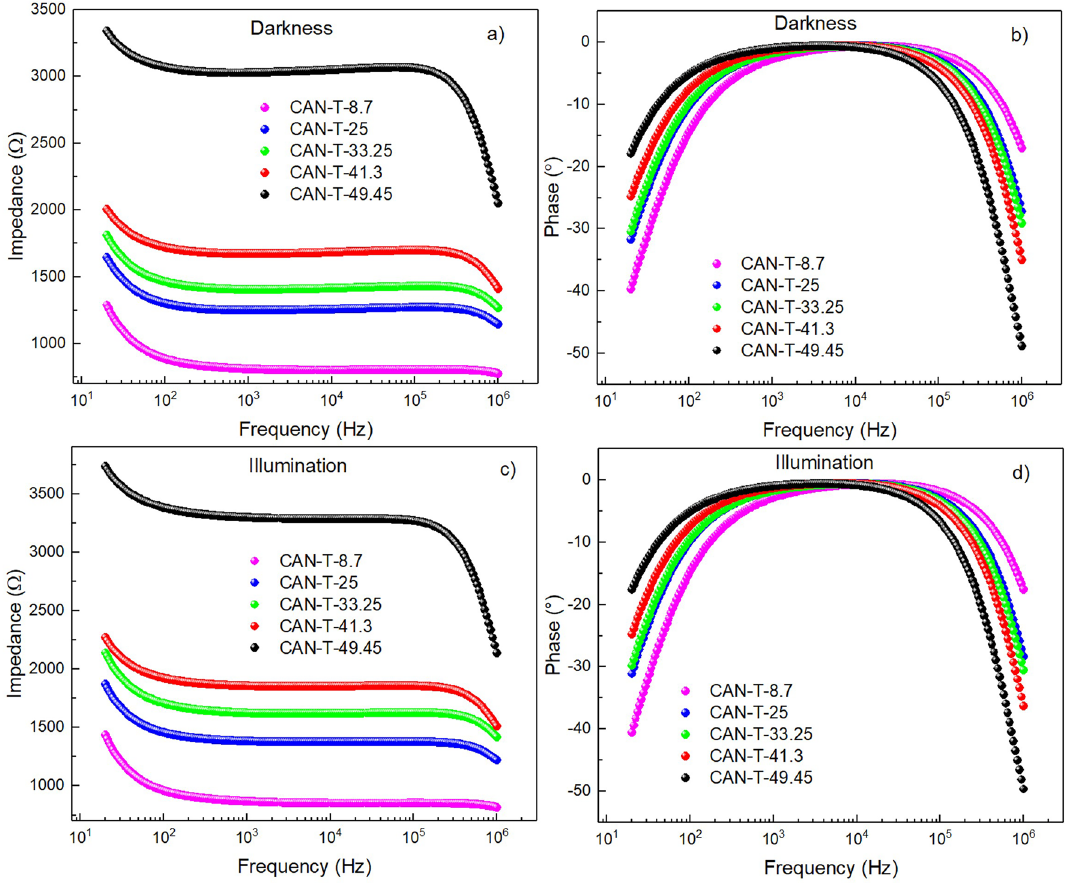
Figure 8. Bode plots of the samples CAN-T in dark ( a ) impedance, ( b ) phase; under illumination, ( c ) impedance, and ( d )